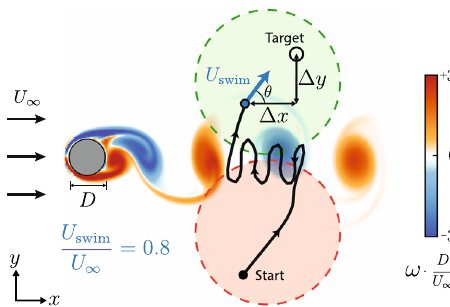
Fig. 1 Test navigation problem of navigating through unsteady cylinder fl ow. Swimmers are initialized randomly inside the red disk and are assigned a random target location inside the green disk. These regions of start and target points are 4 D in diameter, and are located 5 D downstream and centered 2.05 D above and below the cylinder. Additionally, each swimmer is initialized at a random time step in the vortex shedding cycle. An episode is successful when a swimmer reaches within a radius of D /6 around the target